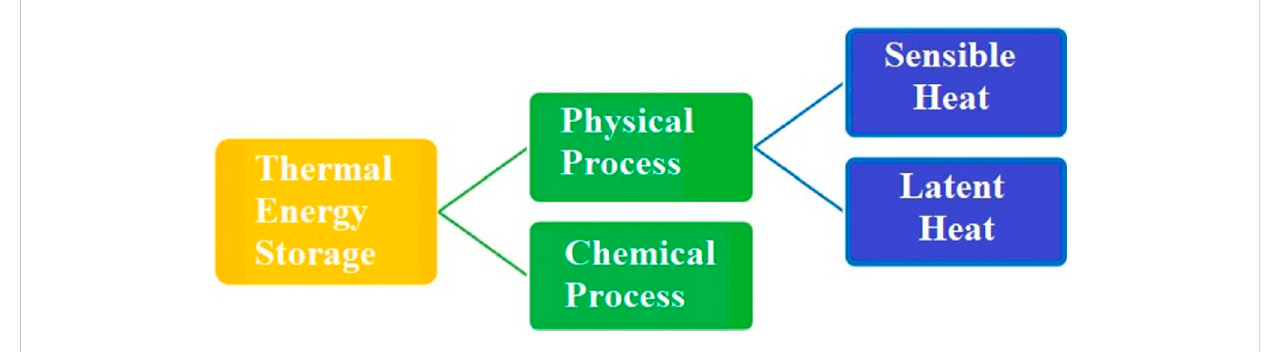
FIGURE 1 Thermal energy storage system (Jouhara et al.,